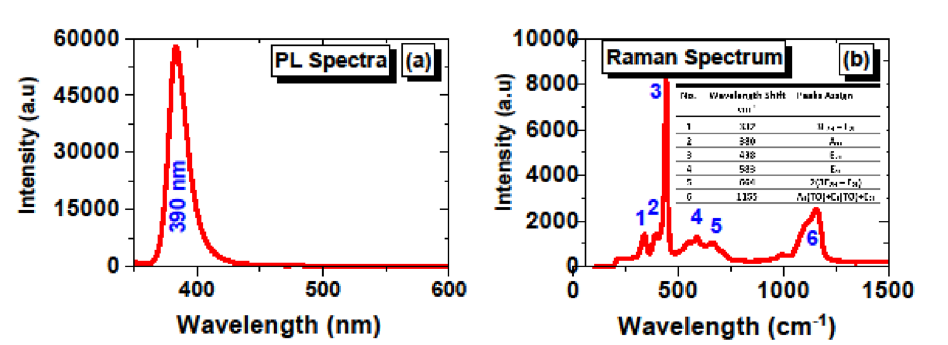
Figure 4. ( a ) PL and ( b ) Raman spectra of ZnO thin